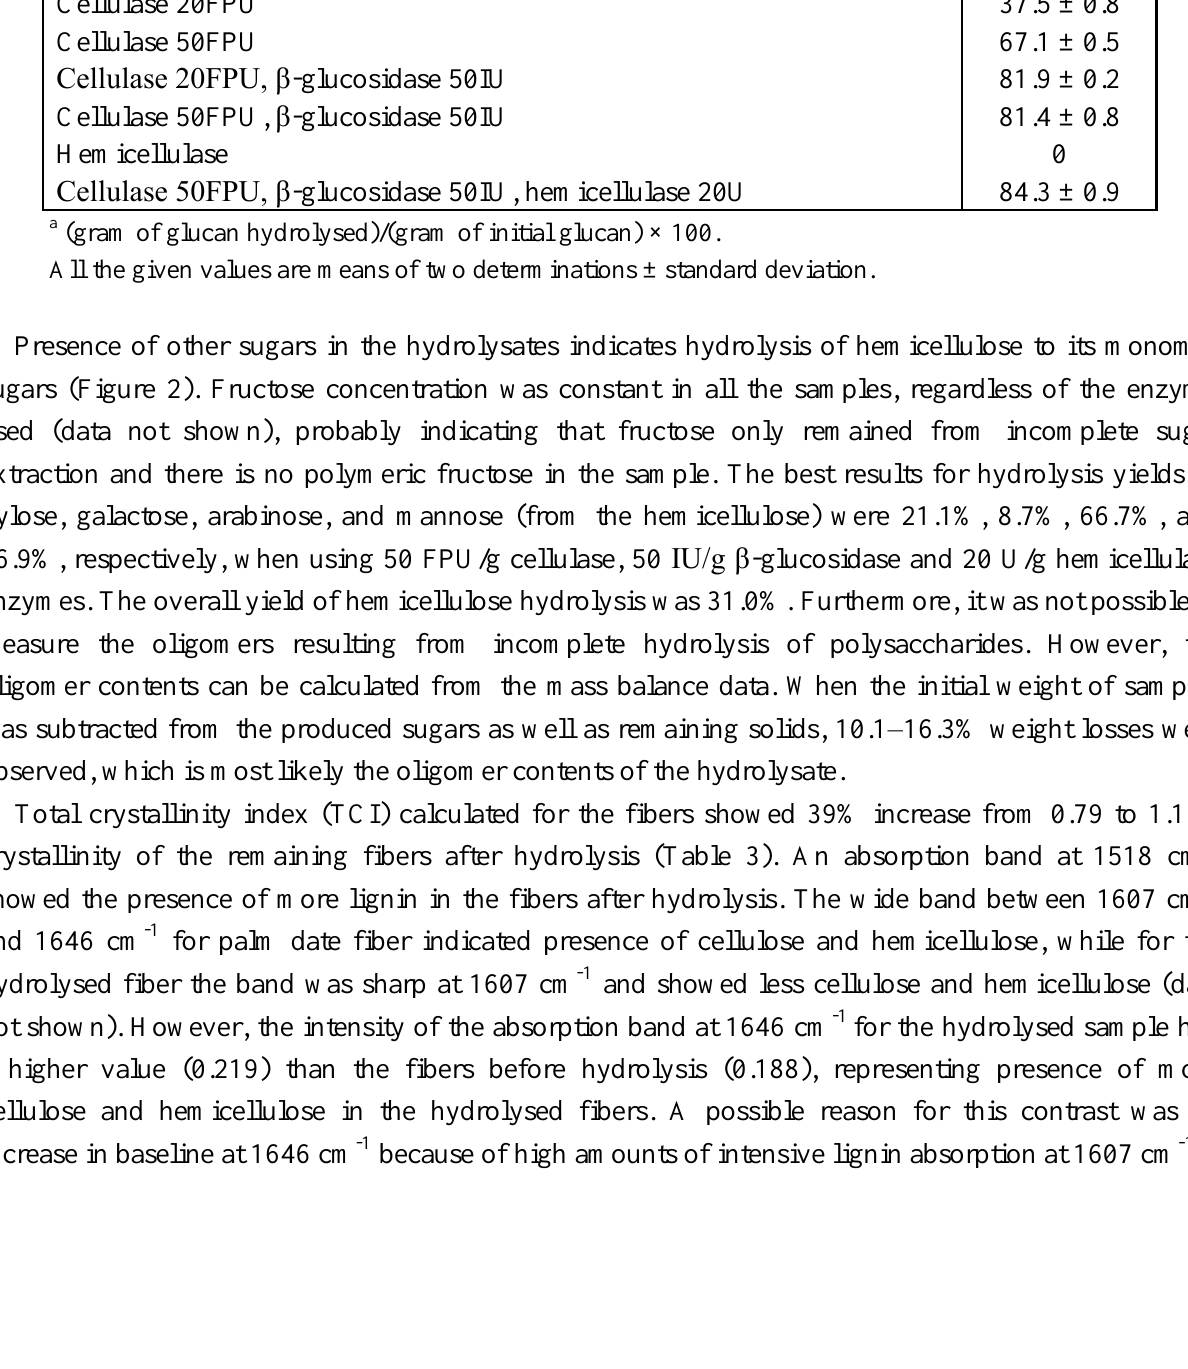
Table 4. Yield of enzymatic hydrolysis of hemicellulose in date flesh solid part. Applied enzymes in enzymatic